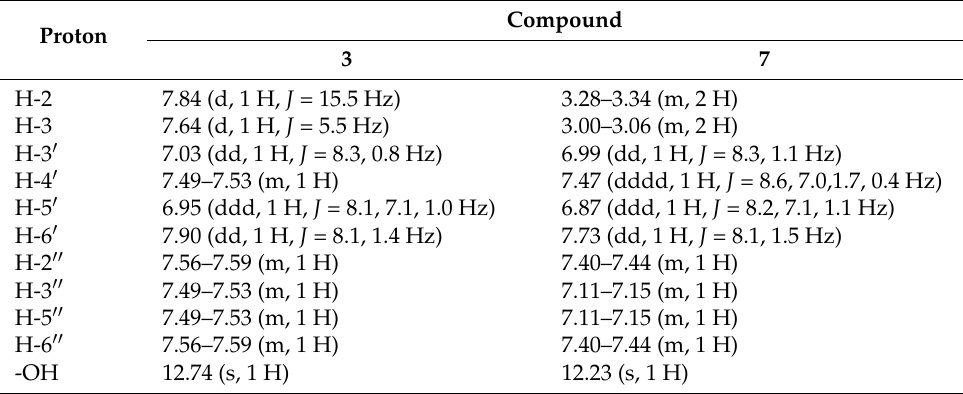
Table 6. Summary of signals visible in the 1 H NMR spectrum of the substrate ( 3 ) and the biotransfor- mation product ( 7